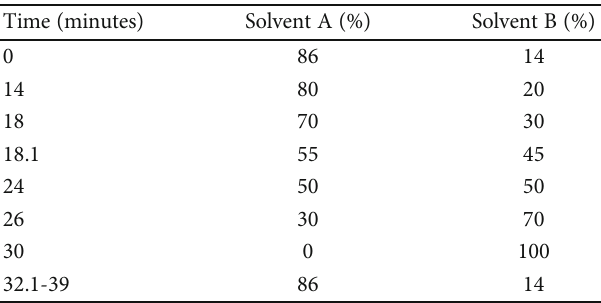
Table 1: Gradient elution scheme for amino acid pro fi le